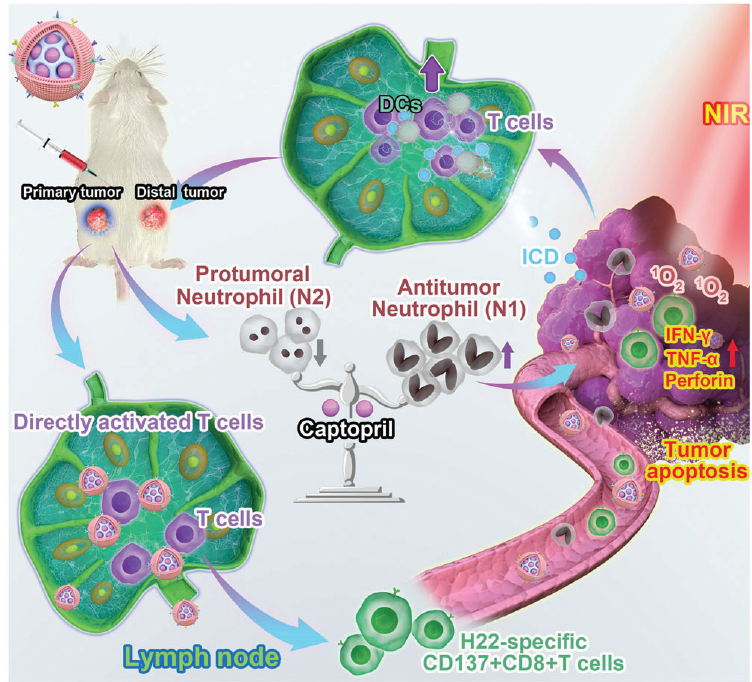
Figure 2. Illustration of an example using well-designed mesoporous silicon as an immunotherapy vector for liver cancer. Captopril is the cargo of MSNs for targeted delivery to lymph nodes, while DCs membranes are highly selective envelopes. Through the protection of MSNs and the targeting of DCs membranes, captopril release induces neutrophil differentiation and infiltration, thus achieving the regulation of tumor local immune microenvironment. Reprinted with permission from Ref. [39]. Copyright 2022 John Wiley and